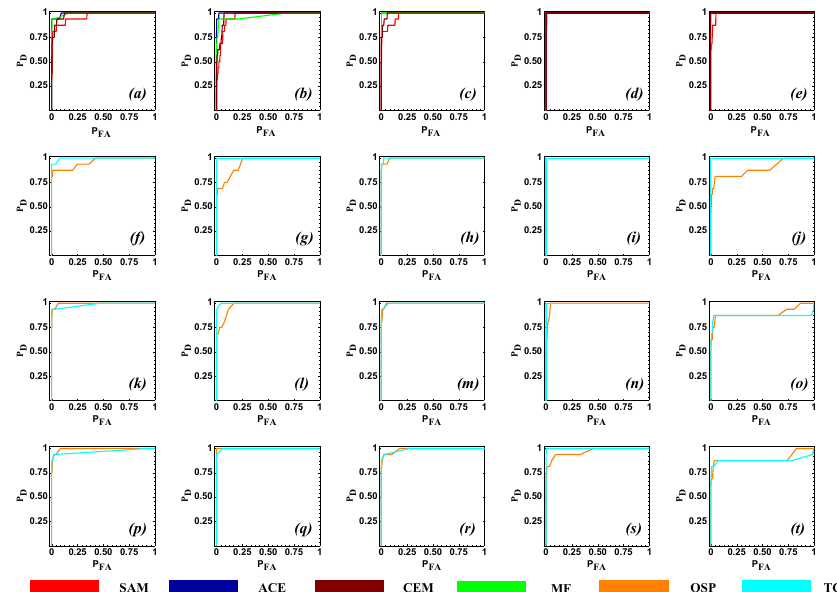
Figure 13. Target detection performance comparison in airborne imagery for the airborne target spectra. ROC curves for the detection from SAM, ACE, CEM, and MF for the ( a ) N1G, ( b ) N2R, ( c ) N3Y, ( d ) C1W, and ( e ) N4B targets. ROC curves for the subspace-based detector OSP and TCIMF for the N1G, N2R, N3Y, C1W, and N4B targets for ( f – j ) 5, ( k – o ) 10, and ( p – t ) 15 endmember / background materials.